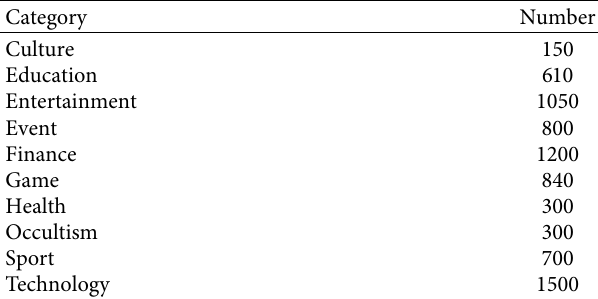
Table 2: The number of Chinese unbalanced corpora.